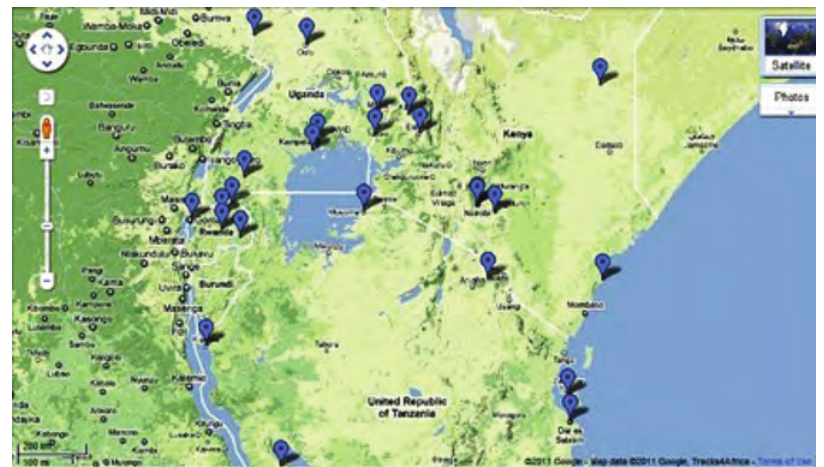
FIGURE A8.3. Location of Satellite